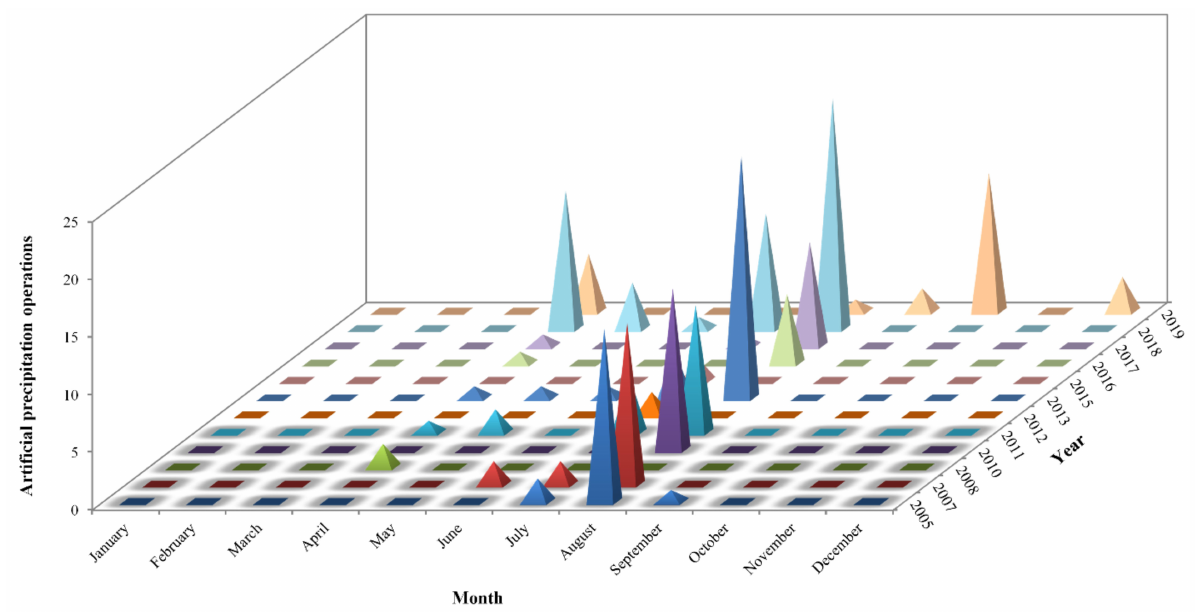
Figure 12. Statistics of artificial precipitation enhancement operations in HSDC,